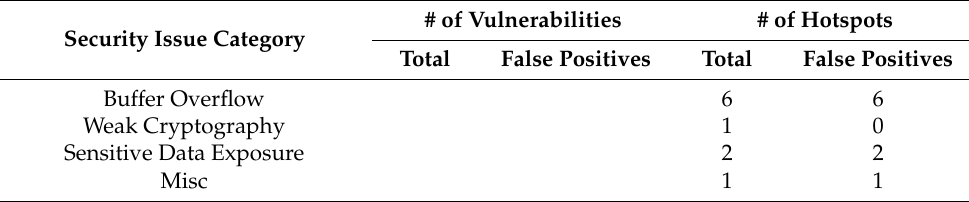
Table 14. Number of security issues of different categories in the Minnow Server.